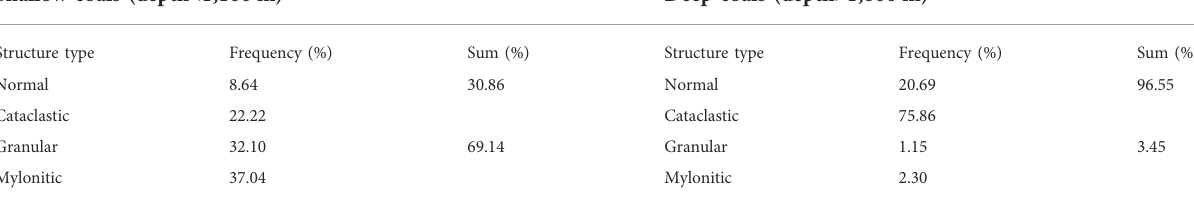
TABLE 1 Statistical comparison of coal-body structure between shallow and deep coals in Linxing Block.